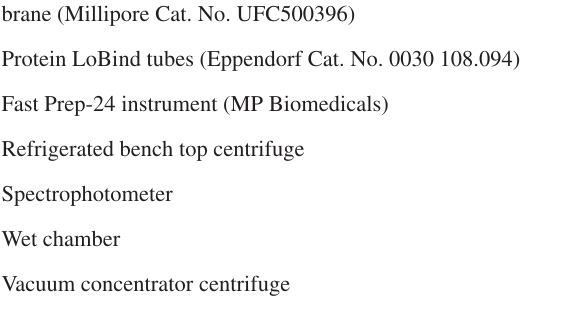
(Bluemlein, K, Ralser, M. Monitoring protein expression in